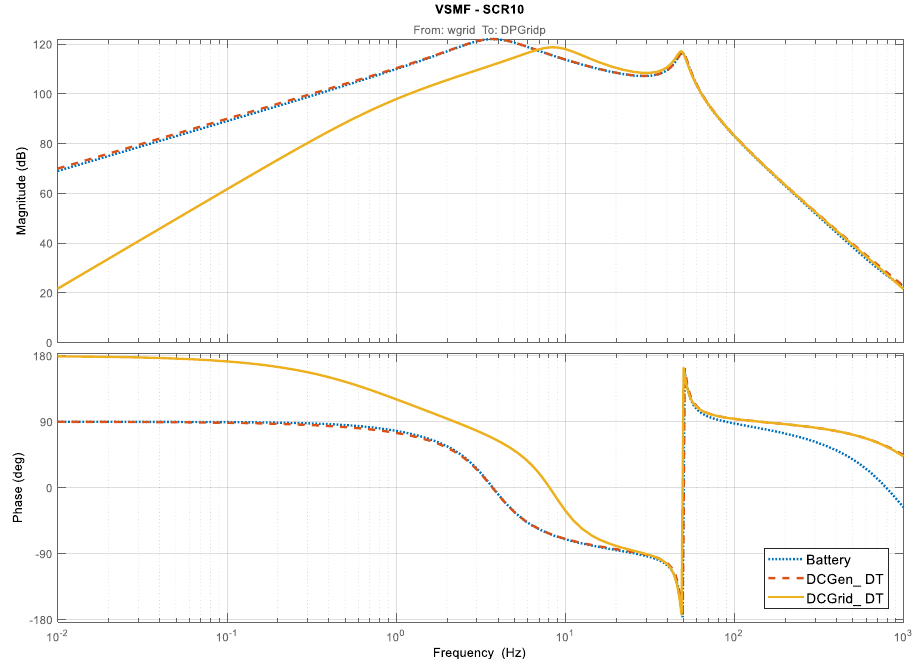
Figure 15. Bode plots comparing frequency responses for DC link voltage control location for VSM controller.